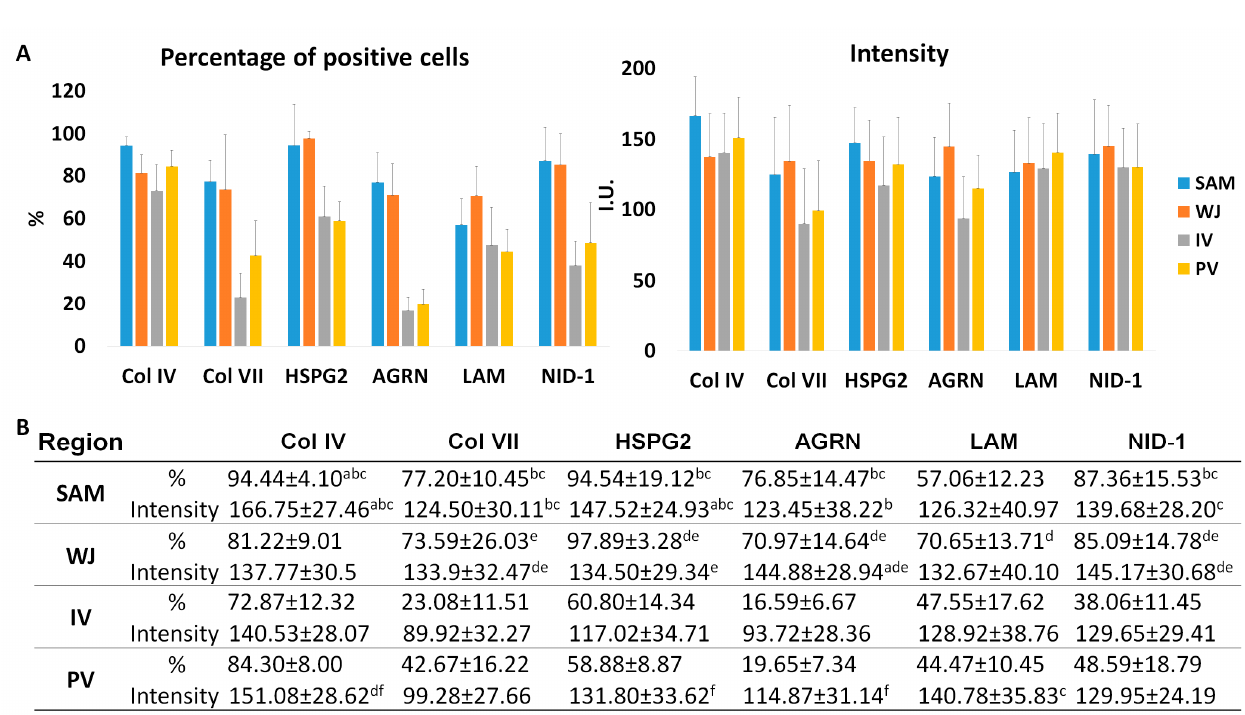
Figure 4. Graphical representation ( A ) and quantitative data ( B ) of percentage of positive cells and positive signal intensity (I.U: intensity units) for BM components (collagen type IV and VII (Col IV and Col VII), proteoglycans heparan sulfate proteoglycan 2 (HSPG2) and agrin (AGRN) and glycoproteins laminin (LAM) and nidogen-1 (NID-1)) expression by regions in full-term human UCs. Results are shown as mean ± SD values for each variable. Sub-amnion (SAM), Wharton’s Jelly (WJ), intervascular (IV) and perivascular (PV). Significant differences between regions are indicated as follows; a: SAM vs. WJ; b: SAM vs. IV; c SAM vs. PV; d: WJ vs. PV; e: WJ vs. IV; f: IV vs. PV.